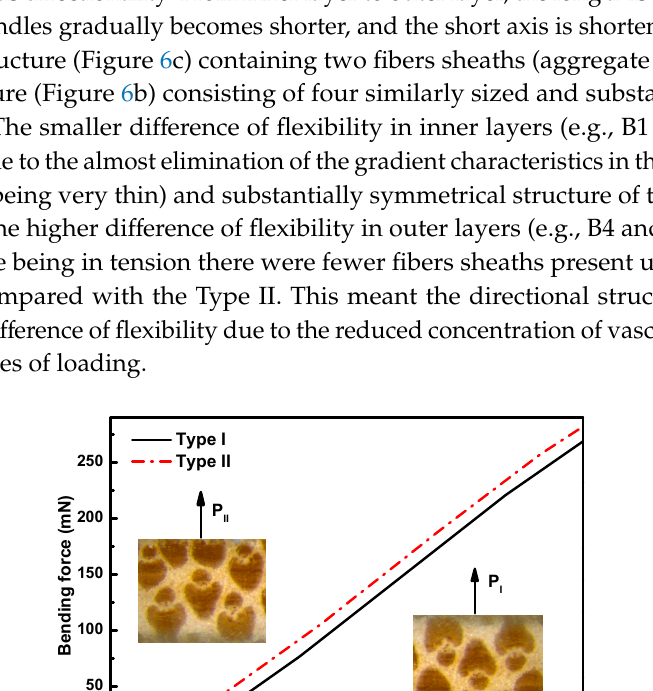
Figure 8. Flexibility of the same sample under different loading Types. 3.3. Modeling and Predicting of the Gradient Bending Flexibility In light of the exhibited graded bending behavior along the thickness of the bamboo strips, the classical model given by Equations (4), the rule of mixtures, was introduced to quantitatively analyze relationships between the elastic modulus, component content, and predict elastic mechanical properties of materials at certain fiber contents. (1